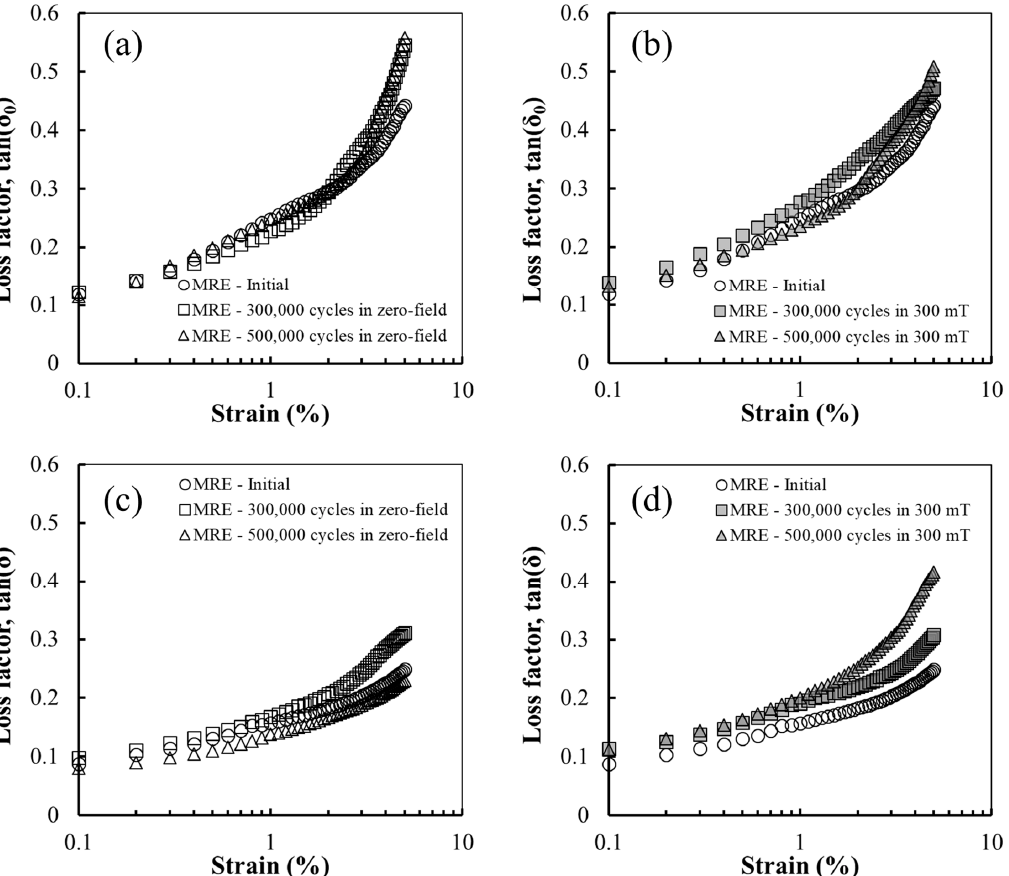
Figure 5. Off-state tan( δ 0 ) of the MRE sample before and after cyclic shear fatigue in the ( a ) absence and ( b ) presence of a magnetic field. On-state tan( δ ) of the MRE sample before and after cyclic shear fatigue in the ( c ) absence and ( d ) presence of magnetic field.